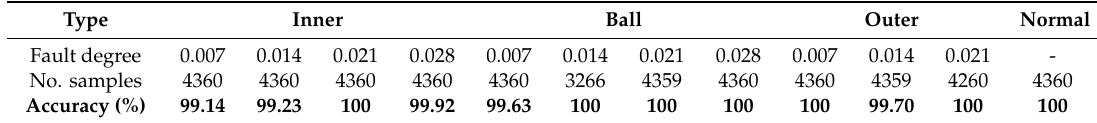
Table 5. Recognition results for di ff erent fault